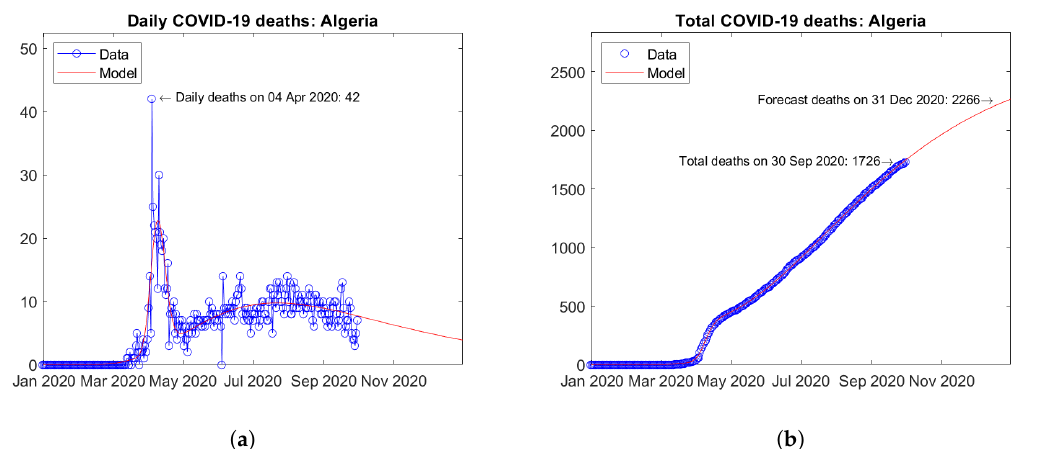
Figure 29. Actual and predicted trends in Algeria: ( a ) daily deaths, ( b ) total deaths.